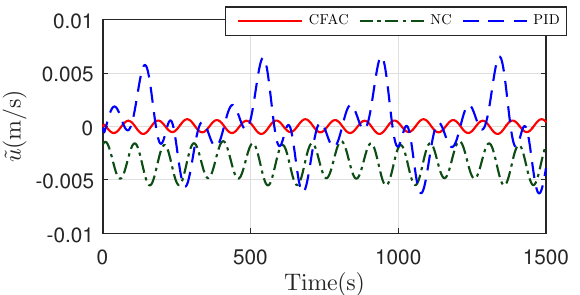
Figure 11. Velocity tracking error in submerging motion with a constant velocity and variable pitch angle command.